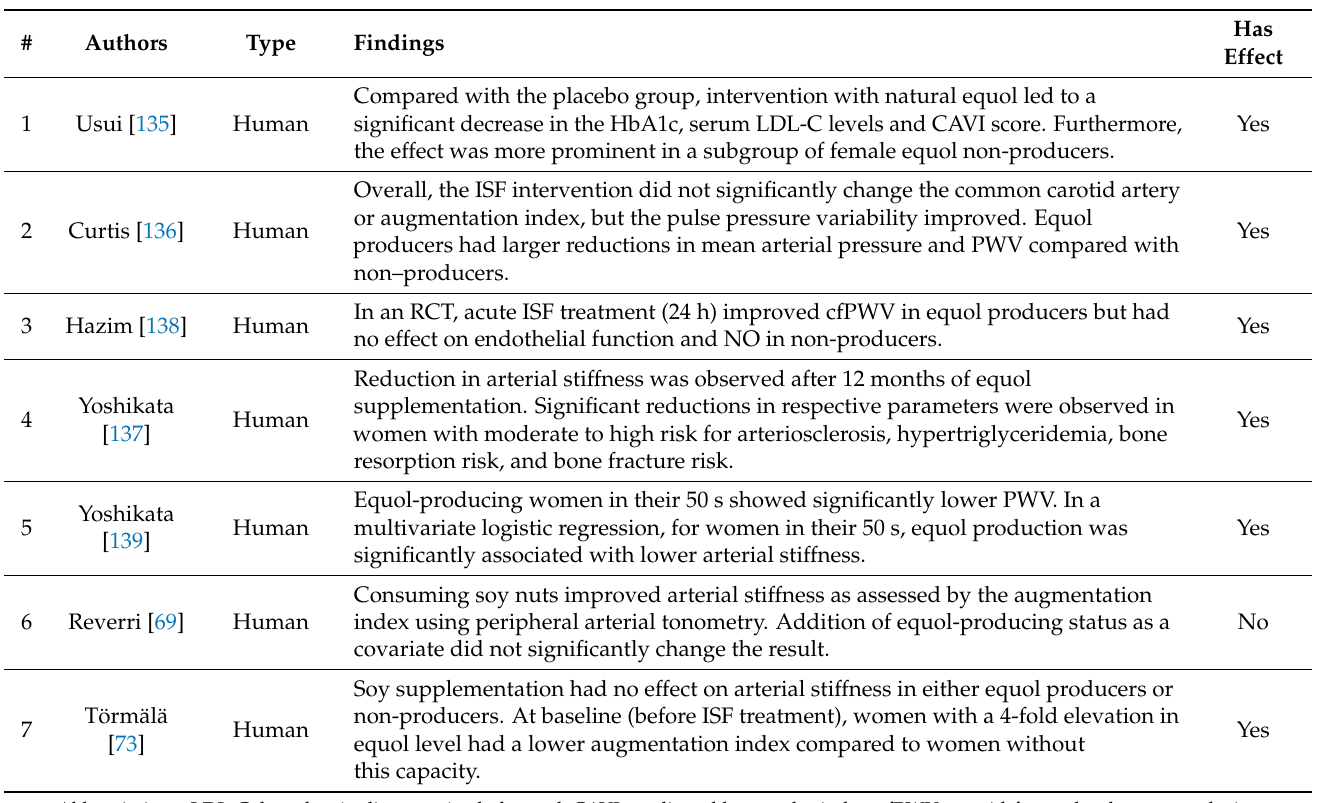
Table 4. Arterial stiffness preventive effects of